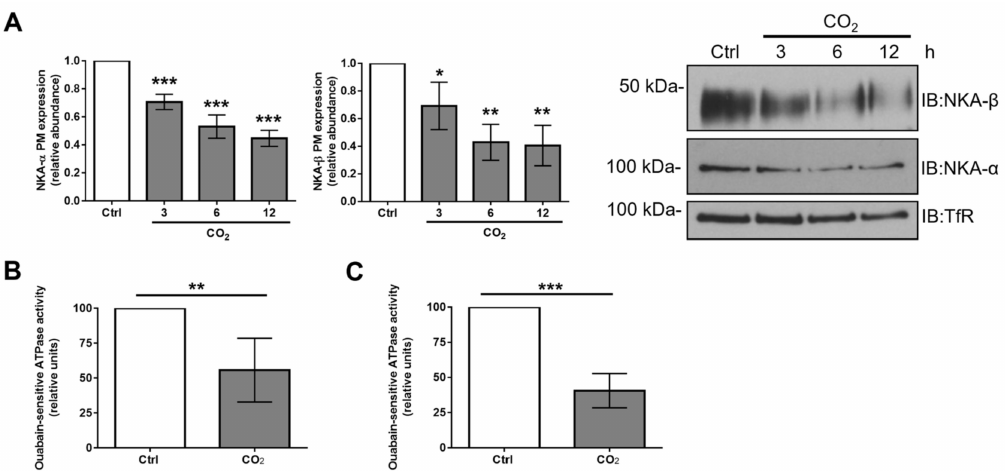
Figure 2. Exposure to elevated CO 2 levels for up to 12 h decreases Na,K-ATPase plasma membrane abundance and function. ( A ) A549 cells were exposed to 40 (Ctrl) or 120 mmHg CO 2 (CO 2 ) for di ff erent time-points. Plasma membrane (PM) abundance of NKA- α and NKA- β was determined by biotin-streptavidin pull-down and immunoblotting. Representative immunoblots of NKA- α , NKA- β , and transferrin receptor (TfR) at the PM are shown. Bars represent the NKA- α or NKA- β / TfR ratio. Values are expressed as mean ± SD ( n = 3, * p < 0.05, ** p < 0.01, *** p < 0.001). ( B ) Primary rat ATII and ( C ) human A549 cells were exposed to 40 (Ctrl) or 120 mmHg CO 2 (CO 2 ) with extracellular pH = 7.4 for 12 h. The PM fraction was isolated by ultracentrifugation and ouabain-sensitive NKA activity was measured by using a colorimetric ATP bioluminescence assay kit. Values are expressed as mean ± SD ( n = 5, ** p < 0.01, *** p <